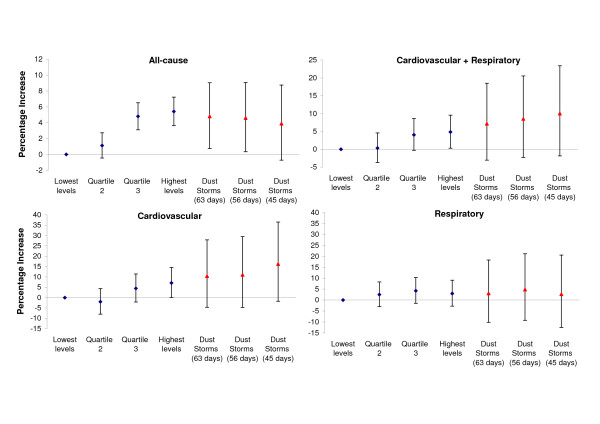
Hospital admissions on dust storm days as compared to non-storm days. Percentage increase (and 95% CI) in all, cardiovascular and respiratory admissions across quartiles of days with increasing levels of particulate matter (PM10), compared to the quarter of days with the lowest levels, after adjusting for seasonality and the confounding effect of weather. Shown separately, the estimated percentage increase in admissions on dust-storm days (n = 63 all candidate days, 56 confirmed dates irrespective of levels of PM and 45 confirmed dates with the highest levels of PM). Note: scales are not comparable across graphs.